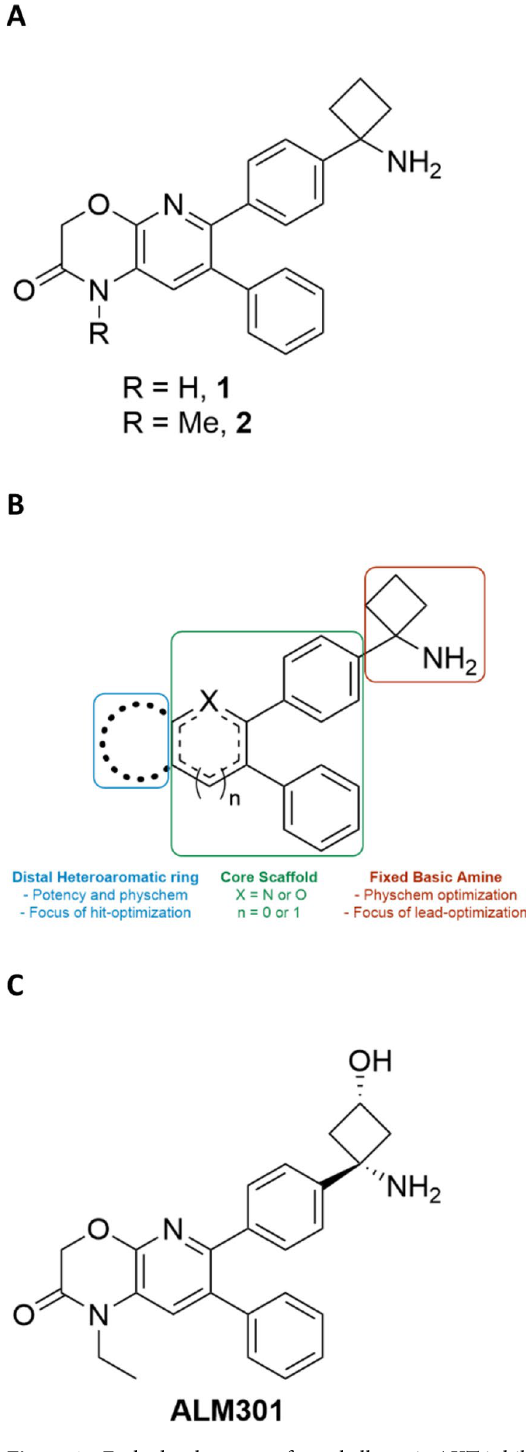
Figure 1. Early development of novel allosteric AKT inhibitors based on a bicyclic pyrido-oxazinone core. ( A ) Chemical structures of early lead chemotypes used as starting points for medicinal chemistry development. ( B ) Hit and lead-optimization strategies employed. ( C ) Chemical structure of development candidate